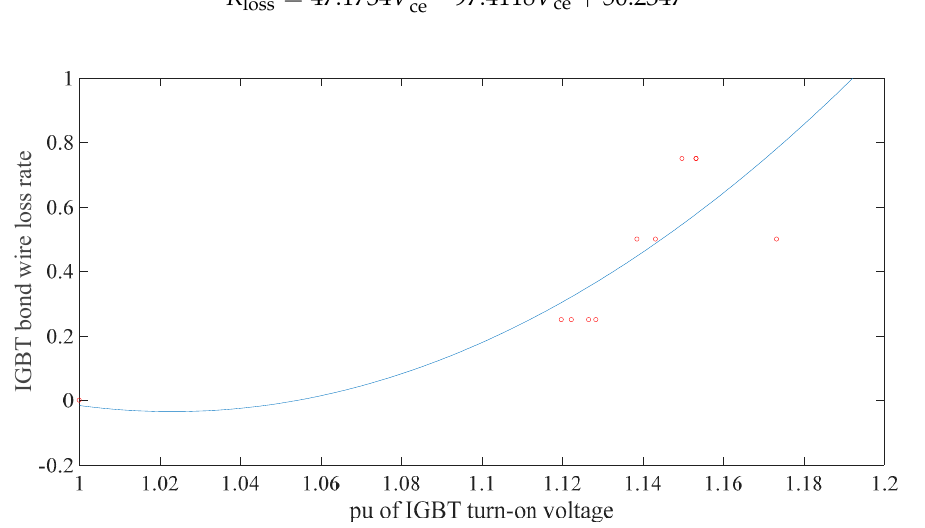
Figure 18. Fitted function between the univariate V ce * and R loss.